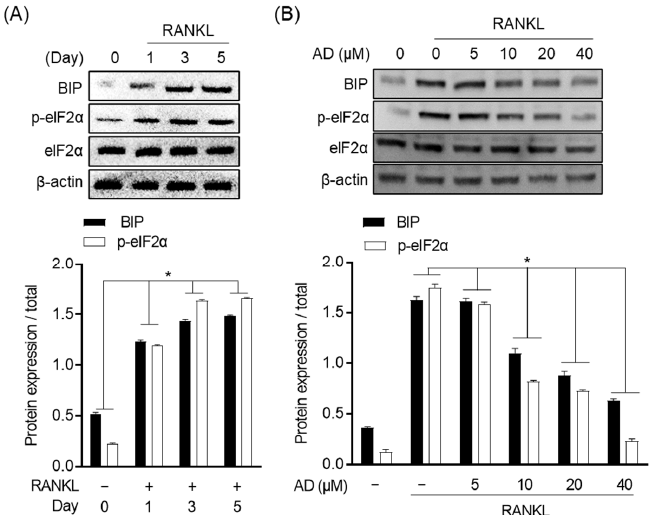
Figure 5. Inhibitory effect of AD on ER stress in RANKL-induced osteoclast. RAW 264.7 cells (1 × 10 4 cell/mL) were seeded in 6-well plate and incubated for 24 h. ( A ) Cells were treated with